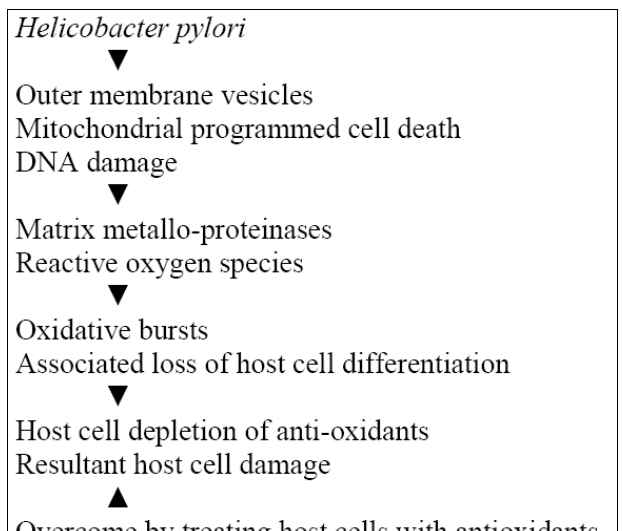
Figure 2. H. pylori, oxidative stress and